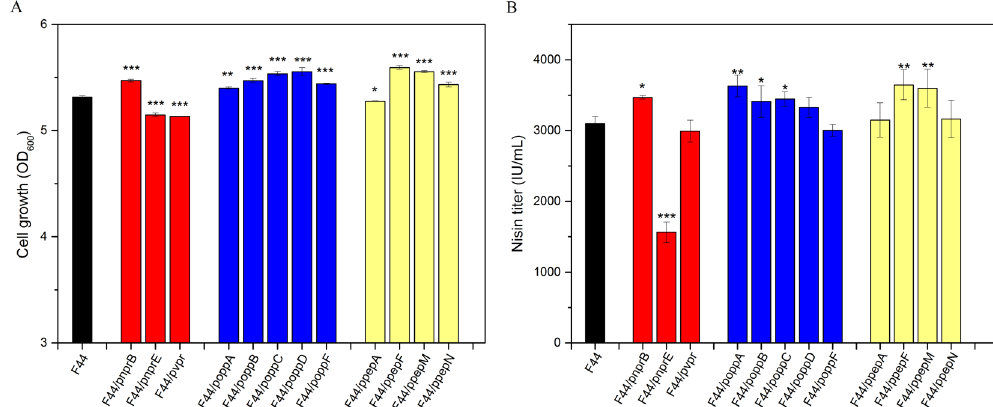
Figure 5. ( A ) Cell density and ( B ) nisin titer of the L . lactis F44 and engineered strains cultured in DSM medium with 25 g/L DSM hydrolysates (8 h anaerobic fermentation at 30 °C). Average data of triplicate experiments were presented. Error bars represent standard deviations from three parallel replicates. The data were analyzed by One-way ANOVA. Statistically significant differences between engineered strain groups and F44 groups were indicated by for * p < 0.05 for ** p < 0.01 and for *** p <